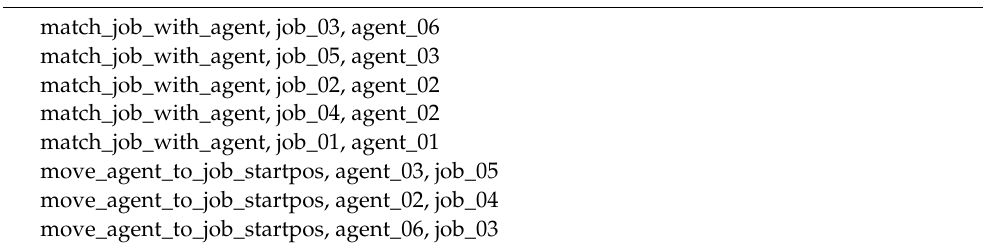
Algorithm 3 An example of the job assignment result for